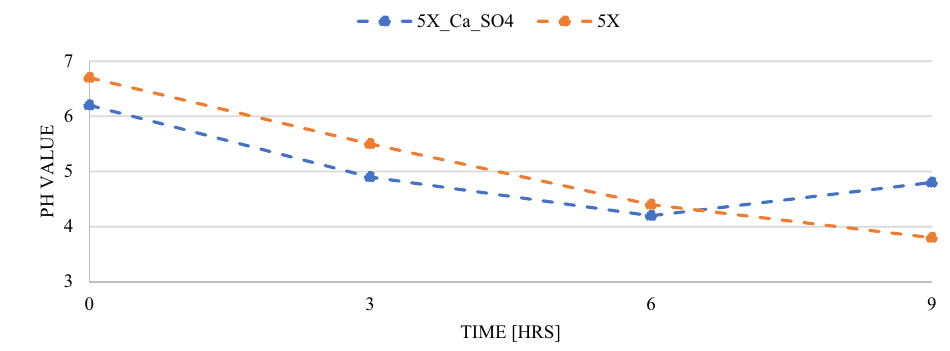
Fig. 9 pH change versus time during aging in 5X_Ca_SO 4 brine